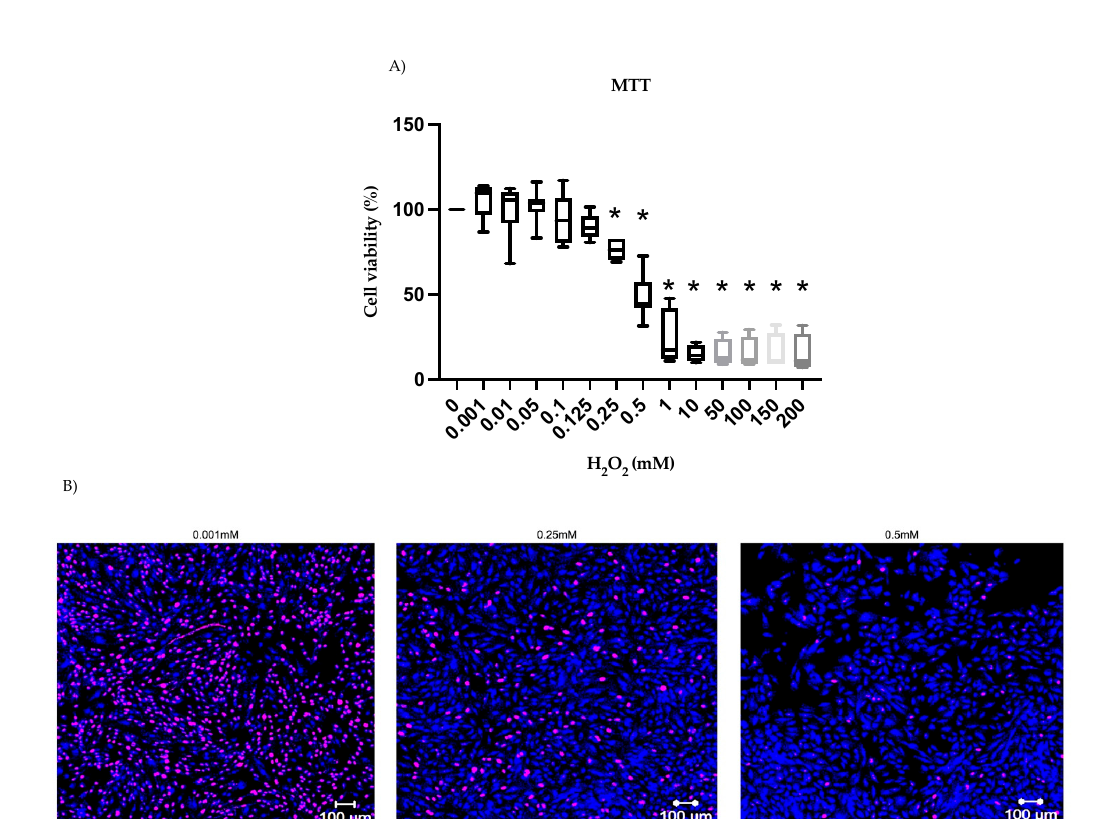
Figure 3. Hydrogen peroxide concentration assay. Stromal cells from endometriotic lesion, eutopic endometrium, and non-endometriosis endometrium were used for the H 2 O 2 assay. ( A ) MTT cell viability test; ( B ) Ki-67 staining in stromal cells. Blue represents cell nuclei, and pink indicates the cells marked for the Ki-67 antigen. * p < 0.05.